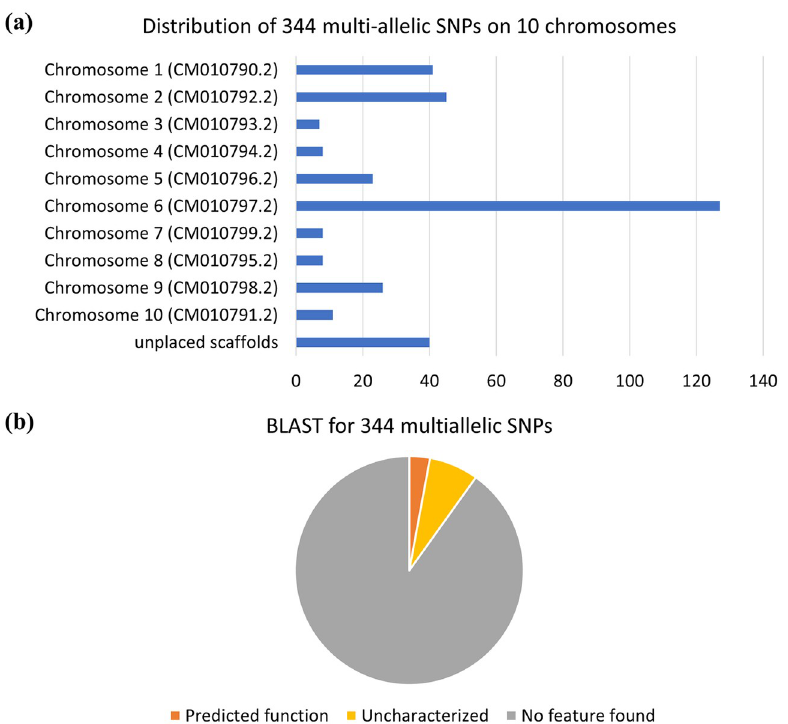
Fig 6. Features of 344 multiallelic SNPs (a) Distribution of structural SNPs on chromosome 1–10 and unplaced scaffolds. (b) BLAST results for structural SNPs against a fully annotated genome.